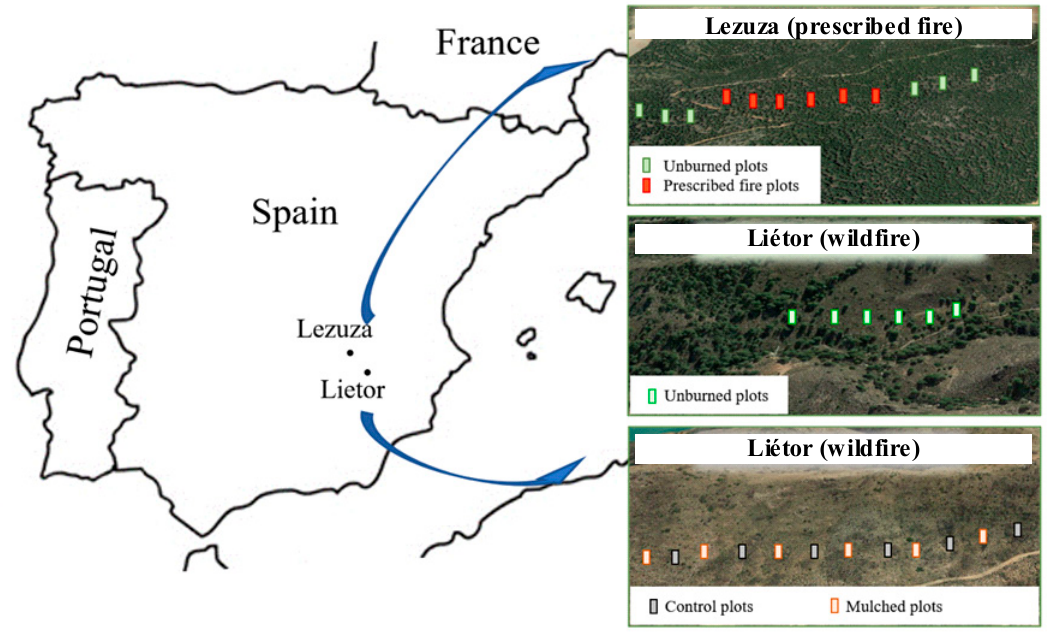
Figure 1. Location and layout of forest plots subject to prescribed fire and wildfire and monitored for hydrological observations (Lezuza and Liétor, Castilla La Mancha, Spain). Geographic coordinates and map source: Lezuza X: 557588 E, Y: 4306475 N; Liétor: X: 600081 E, Y: 4262798 N (unburned area); X: 598358 E, Y: 4264032 N (burned area); Google Earth, last access on 6/15/2019).